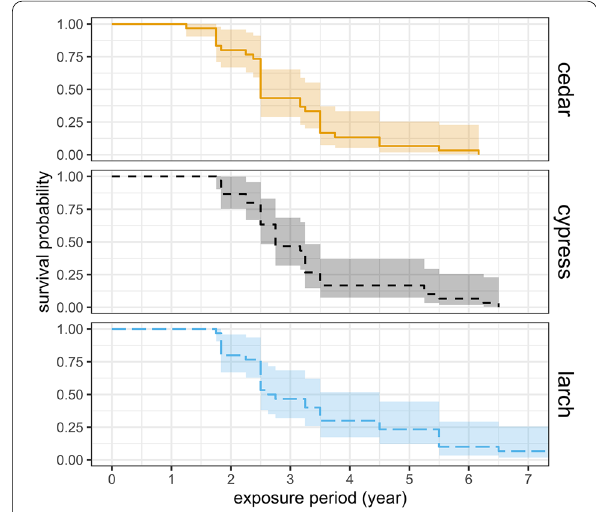
Fig. 6 Kaplan–Meier curves observed for deterioration of all stakes at different sites. Color‑coded areas indicate 95% confidence intervals Table 6 Adjusted p value between each site